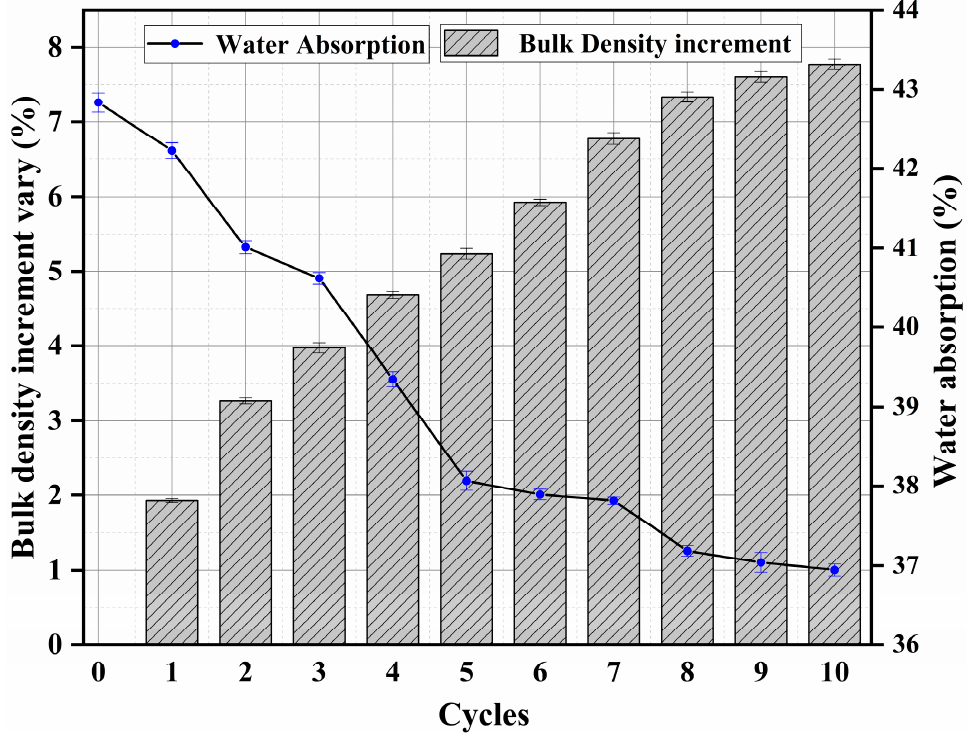
Figure 2. Water absorption and bulk density increment vary with the number of cycles of treat-